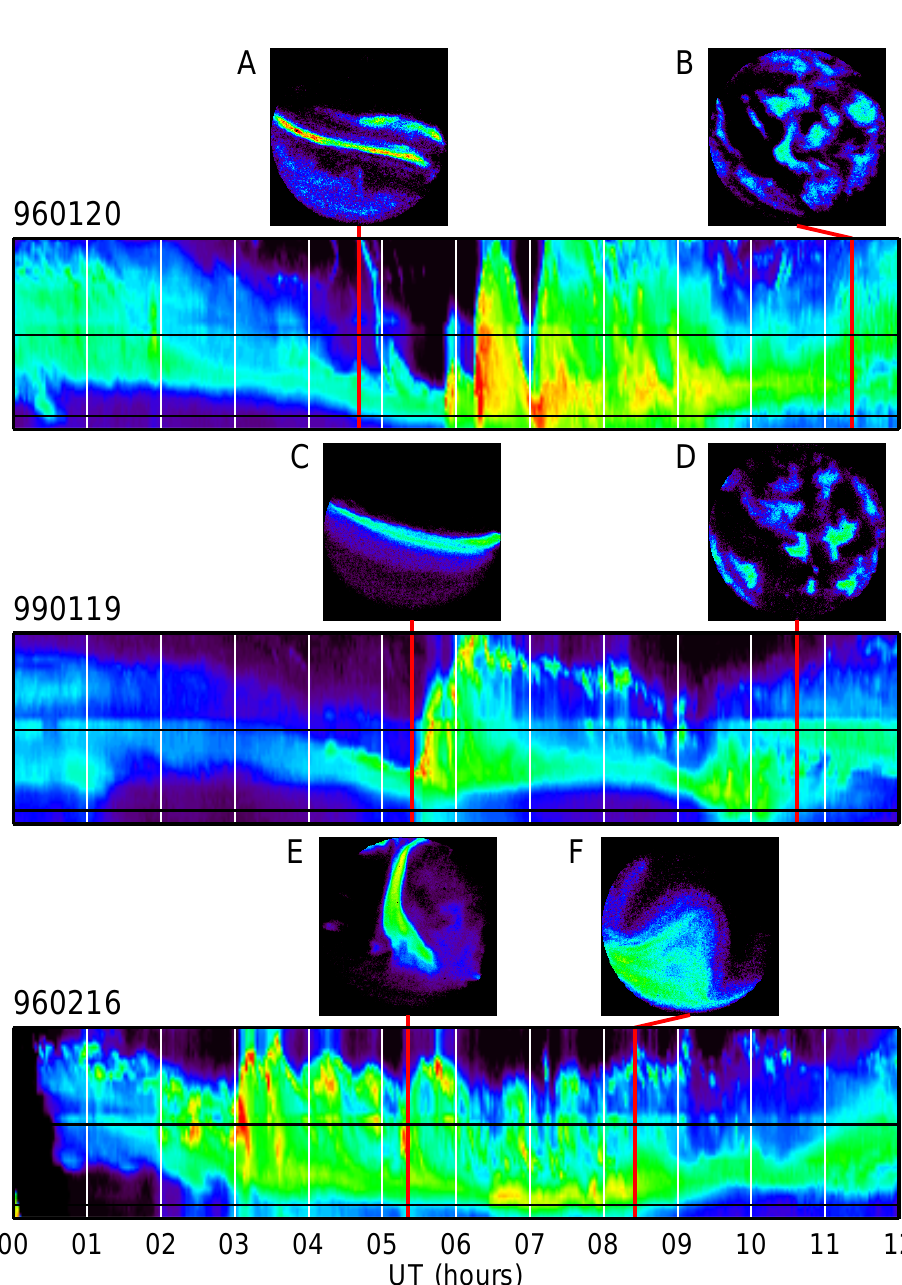
Fig. 3. Keograms from three nights constructed from 558nm data collected by the CANOPUS Gillam and Rankin Inlet MSPs. The latitudinal extent of the ASI FOV is indicated by the two horizontal black lines. We include six 558nm ASI images from Gillam, showing arcs (A) & (C) , patches (A) & (D) , a north-south aligned auroral form (E) , and an Omega-band (F)